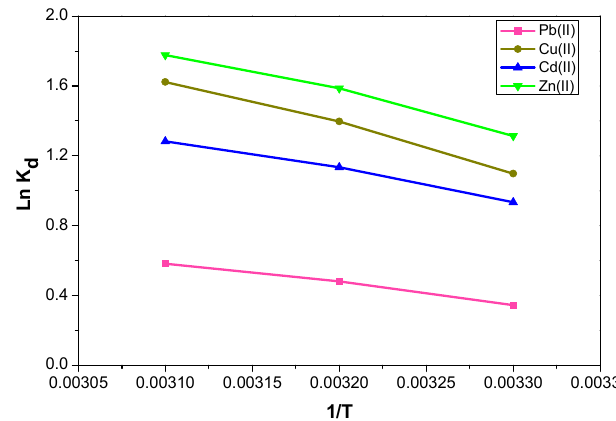
Figure 7. Effect of temperature for the sorption of metal ions onto SiTF 5 PP (contact time: 30 min; Adsorption dose: V = 10 mL, m = 10 mg of SiTF 5 PP using optimum pH (pH = 6), optimum concentration (187.36 ppm in each case), and 25 °C. Lines just combine the points.